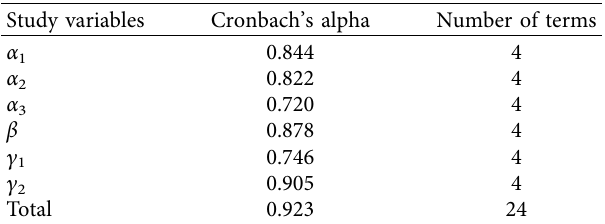
Figure 4: Innovation perspective. Table 2: Cronbach’s alpha coefficient. Table 4: Structural equation model fitting degree